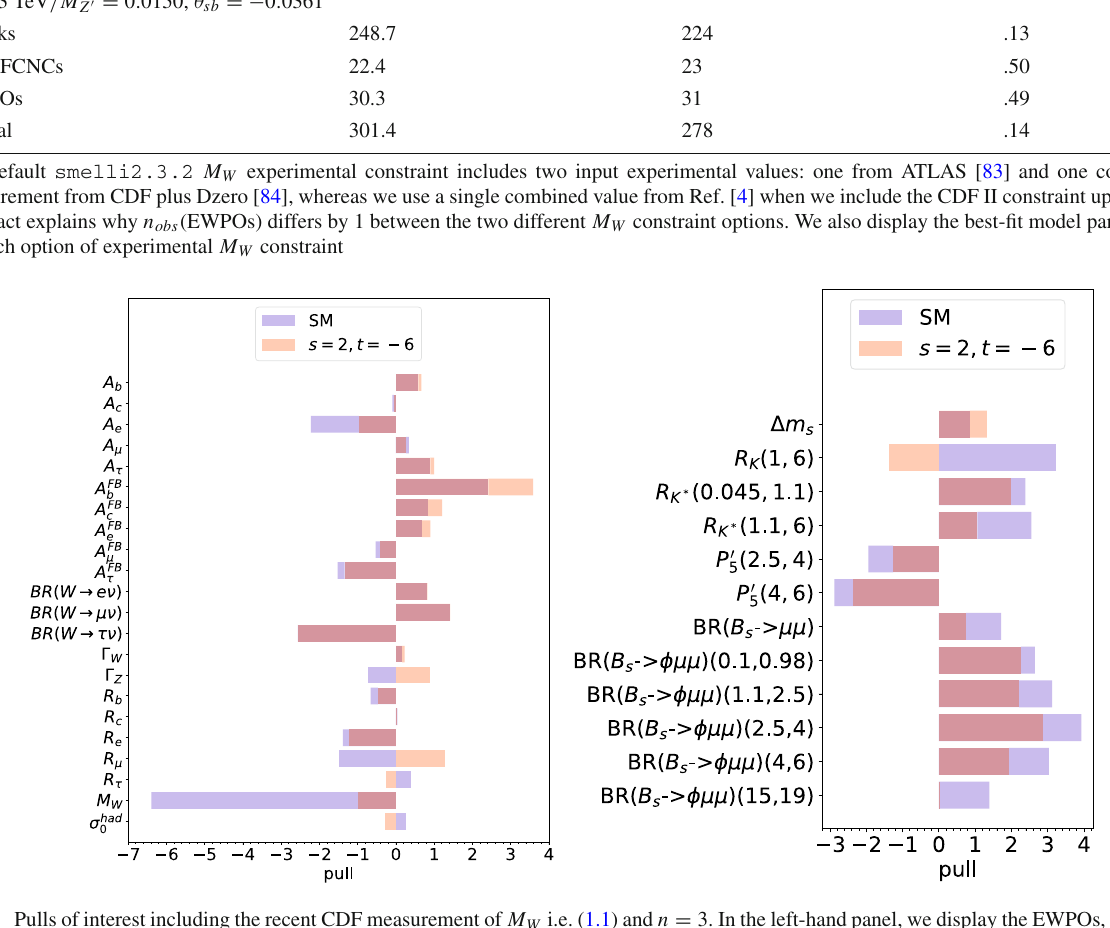
Fig. 2 Pulls of interest including the recent CDF measurement of M W i.e. (1.1) and n = 3. In the left-hand panel, we display the EWPOs, whereas in the right-hand panel, we display selected observables of interest to b → sl + l −